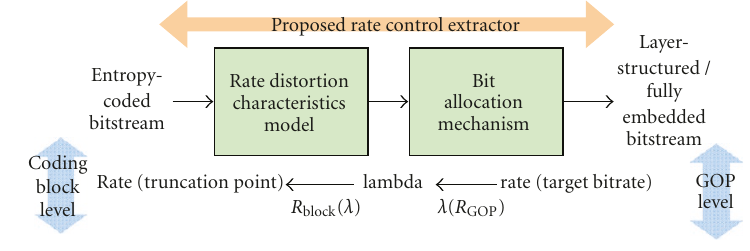
Figure 6: The framework proposed rate control extractor.